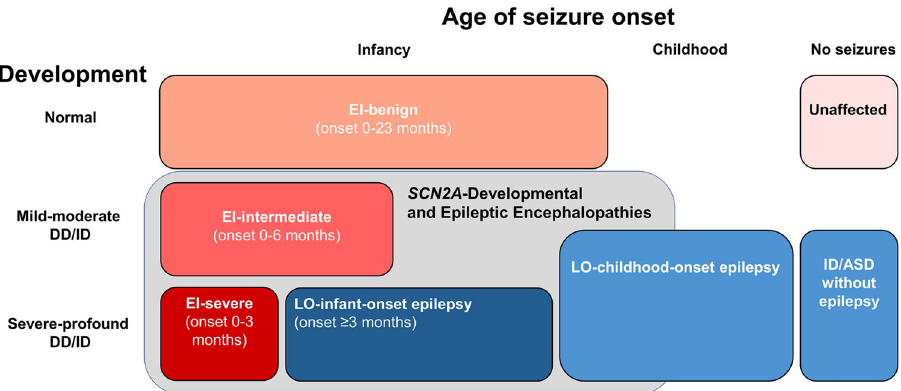
Fig. 6 The phenotypic spectrum of SCN2A-related disorders. Pink/red boxes indicate phenotypes associated with gain-of-function (GoF) of the Nav1.2 channel, and blue boxes loss-of-function (LoF) phenotypes; Onset refers to age of seizure onset. The phenotypic groups associated with more severe epilepsies are sometimes grouped as SCN2A developmental and epileptic encephalopathies (gray box), which encompasses both GoF and LoF phenotypes. The early-infantile (EI) phenotypes can be considered a spectrum of clinical severity associated with biophysical GoF. While the later-onset (LO) epilepsy phenotypes and ID/ASD without epilepsy are both associated with LoF, it is not clear whether these represent a spectrum of severity (related to partial or total loss of channel function), or are distinct disorders caused by different mechanisms of channel hypofunction (for example pure LoF vs dominant negative